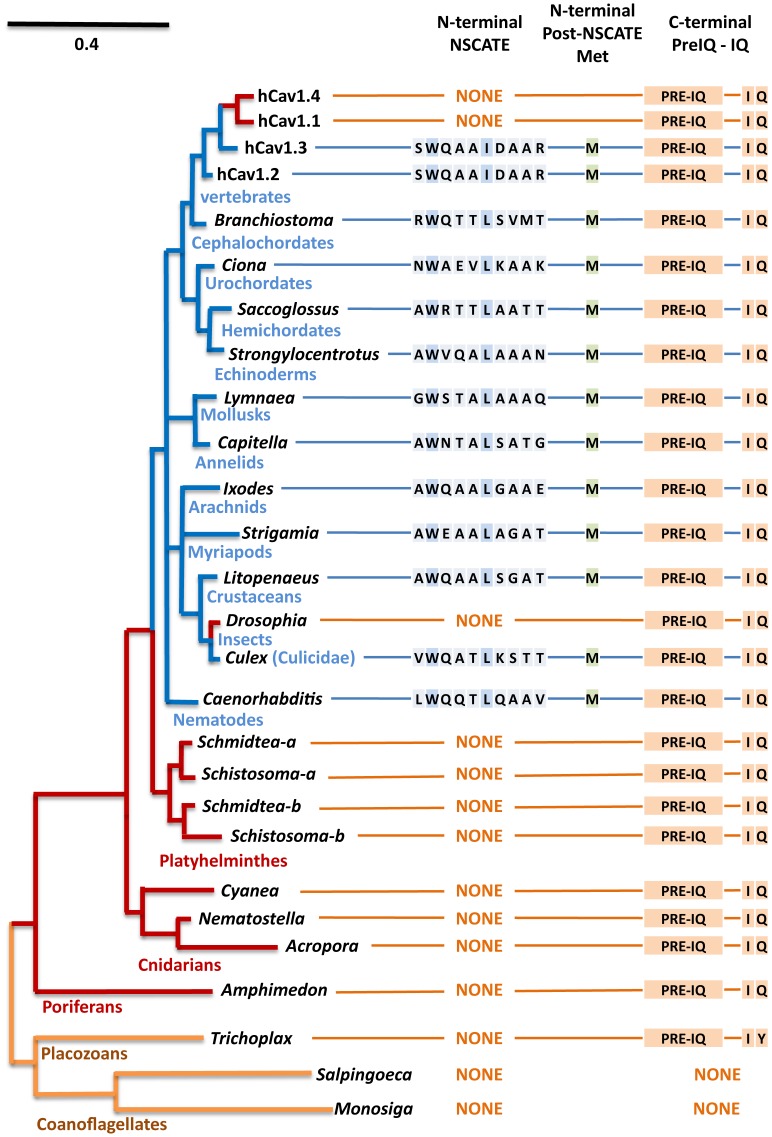
Gene tree of L-type calcium channels illustrating the evolution of calmodulin binding, amino terminal (NSCaTE) and carboxyl terminal (Pre-IQ/IQ) motifs in L-type Cav1 channels.All animal phyla including single cell protozoans (such as Paramecium) and simple multicellular organisms (placozoans, sponge) have an IQ motif. A N-terminal NSCaTE (xWxxx(IorL)xxxx) motif evolved in common invertebrate ancestors (coelomates) and retained in all major phylogenetic groups. While the Pre-IQ and IQ motifs are featured in all L-type channels of metazoans, the NSCaTE motif is missing in some Arthropod species, including many insects, suggesting that NSCaTE is not an essential feature of L-type channels. NSCaTE was lost in Cav1.1 and Cav1.4 after the speciation of L-type channels to four gene isoforms in vertebrates. Almost every NSCaTE containing L-type channel has a downstream methionine (Met2) from the start codon (Met1) which could serve as an alternative translational start site for inclusion (Met1) or exclusion (Met2) of NSCaTE in L-type channels.